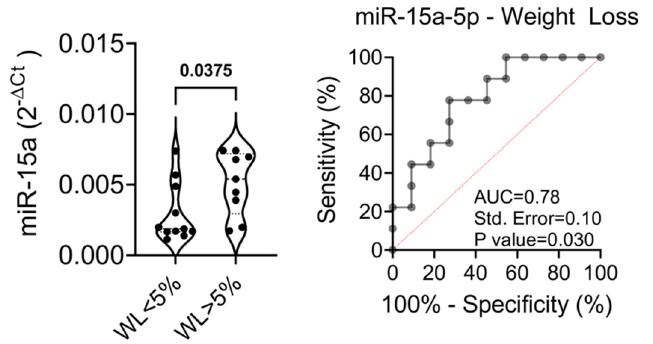
Figure 5. ( Left ) Baseline expression (T0) of miR-15a-5p in patient with WL <5% or >5% at T12. Data are reported as single dot values and mean values of normalized 2 − ∆ Ct . Statistics using non-parametric Mann-Whitney U test. FPG: fasting plasma glucose; WL: weight loss. ( Right ) ROC curve of miR-15a-5p baseline expression levels in the prediction of weight loss outcome at 12 months.